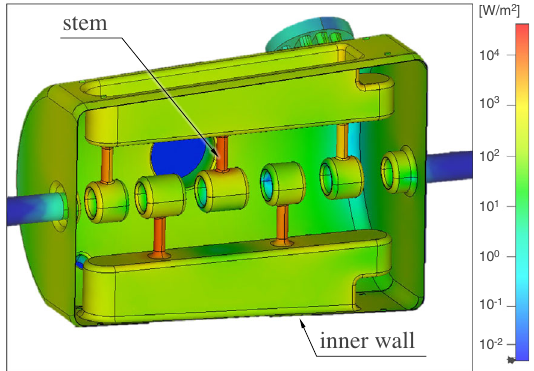
FIG. 14. Simulated power dissipation distribution on the cavity surface with the peak power of 88 kW and nominal duty factor.